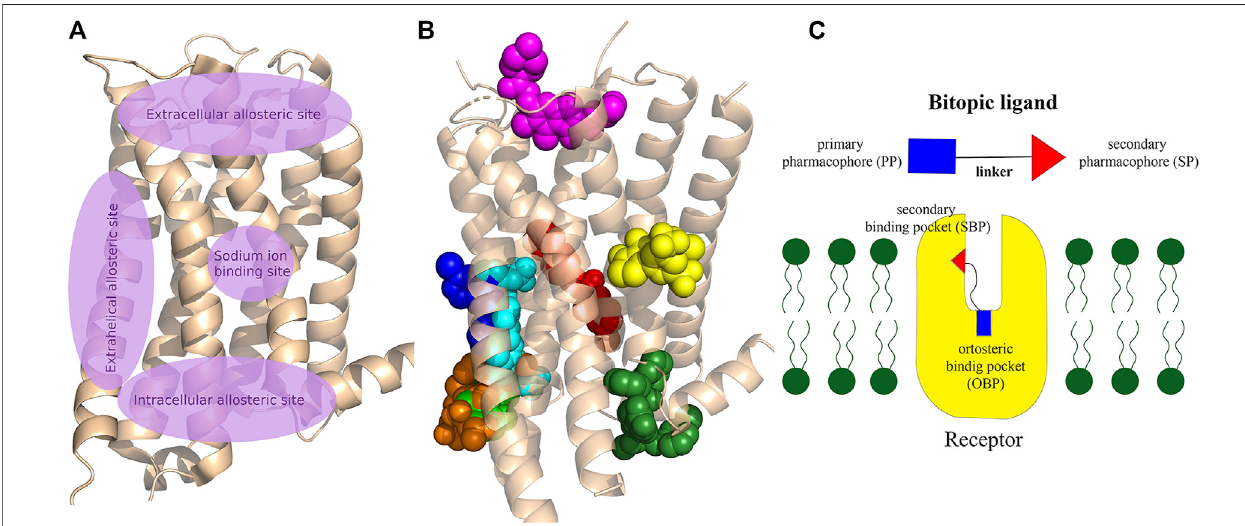
FIGURE 2 | (A) Schematic representation of the main allosteric sites in Class A GPCRs. The OBP, where the endogenous ligands bind to the receptor, is located between the extracellular allosteric site and the sodium binding site, deep in the crevice of the receptor formed by the transmembrane helixes. Some allosteric sites are clearly separated from OBP, while others can be considered as an expansion of the orthosteric pocket. (B) Visualisation of allosteric binding sites for some important compoundsrelatedtothereview:mevidalenintheD 1 R(green,PDBcode:7LJD),AP8inFFAR1(cyan,PDBcode:5TZY),ORG27569inCB 1 (red,PDBcode:6KQI), MIPS521 in A 1 R (yellow, PDB code: 7LD3), LY2119620 in M 2 R (magenta, PDB code:4MQT), Cmpd-15PA in β 2 AR (dark green, PDB code: 5X7D), AS408 in β 2 AR (dark blue, PDB code:6OBA), cmpd-6fa in β 2 AR (orange, PDB code: 8N48). Cholesterol was shown to bind to extrahelical binding sites to different TMs that could not be depicted on the fi gure to maintain clarity. For details please see the recent review of Jakubík and El-Fakahany (2021) and for a review of the allosteric sites at the receptor – lipidbilayerinterfacepleaseseeWangetal.(2021) (C) Schematicstructureofabitopiccompound.TheprimarypharmacophorethatbindstotheOBPislinked through a linker to the secondary pharmacophore binding to the SBP.